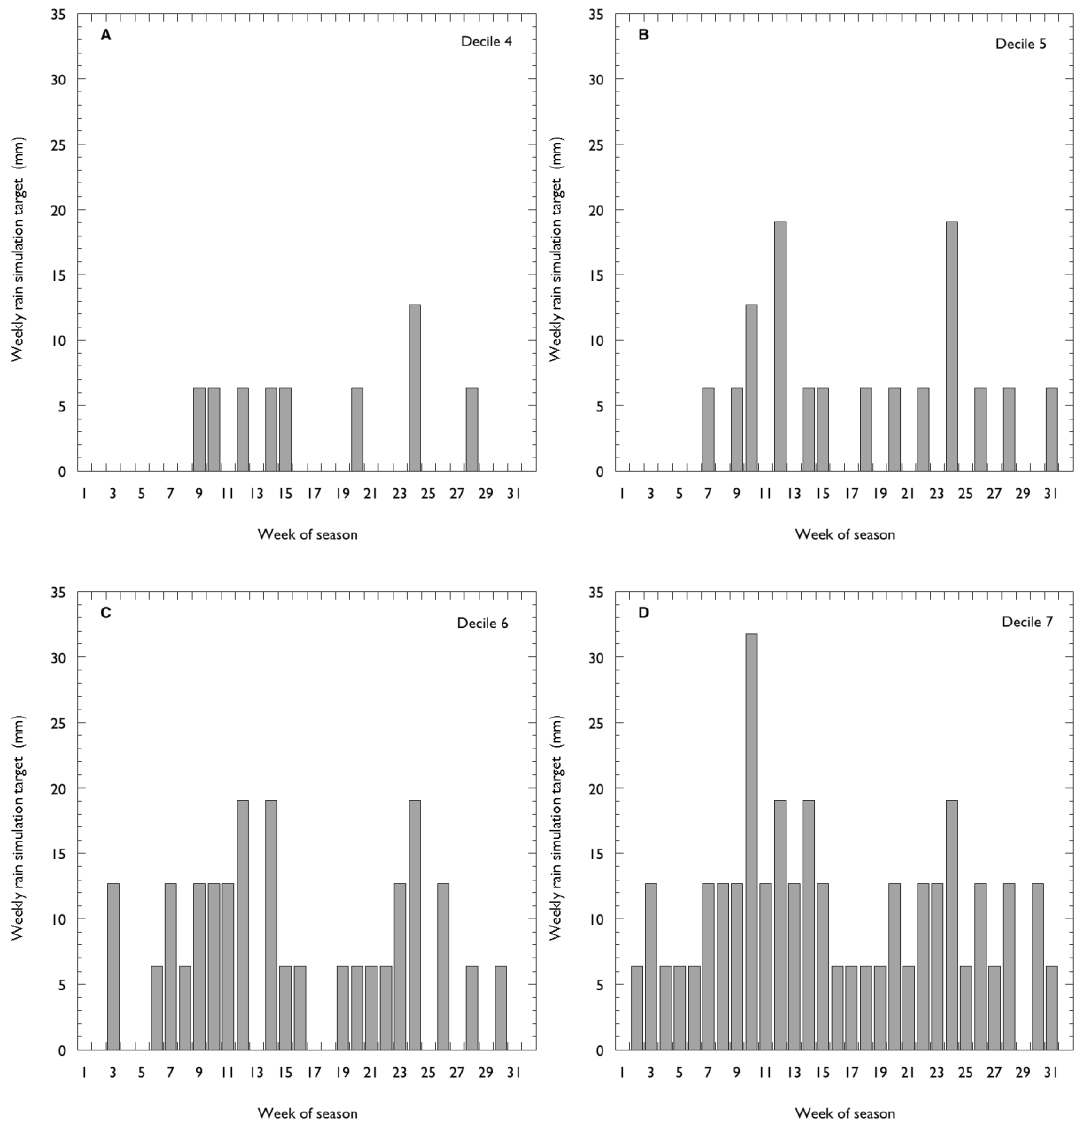
Figure 3. The weekly rain targets for the 4th through 7th decile treatments (panels A – D ) of the rain simulation protocol. Week 1 starts on DOY 90 and week 32 starts on DOY 307. The rain targets are in units of mm.